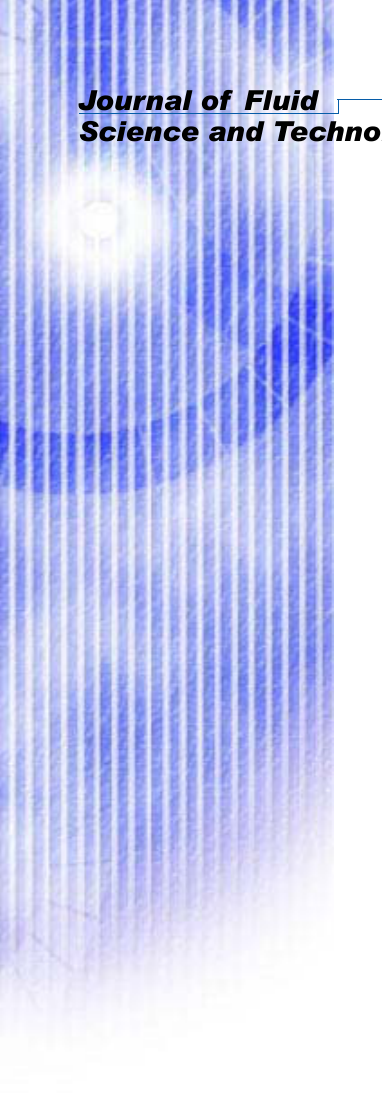
. Thin solid lines in Fig. 9 represent